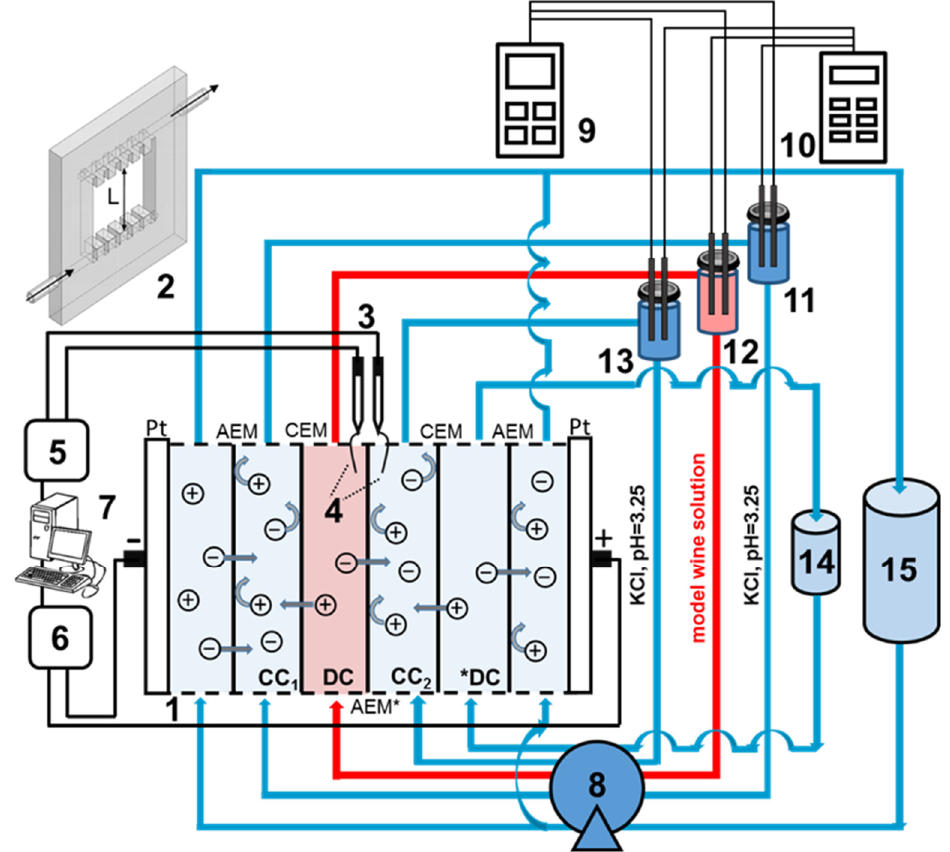
Figure 2. Scheme of the experimental setup: 1—six-compartment flow ED cell, where AEM is an anion-exchange membrane, CEM is a cation-exchange membrane, AEM* is an anion-exchange membrane under study, CC 1 and CC 2 are concentration compartments 1 and 2, respectively, DC is the studied desalination compartment; *DC is an auxiliary desalination compartment; 2 is a schematic representation of the plastic frame of the cell and the solution flows through it, where L is desalination length; 3—Ag/AgCl electrodes; 4—Luggin’s capillaries; 5—multimeter; 6—current source; 7—personal computer; 8—peristaltic pump; 9—pH meter; 10—conductometer; 11–13—intermediate tanks in the DC, CC 1 and CC 2 circuits ; 14—intermediate tank for the solution circulating in the *DC circuit; 15—intermediate tank for the solution circulating in the EC circuits.